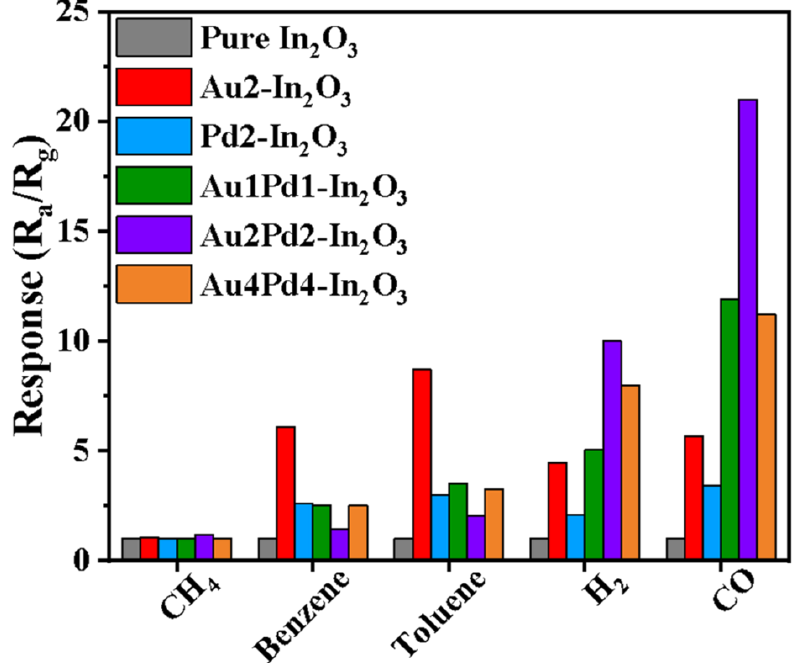
Figure 8. Gas responses of gas sensors based on six samples to various 100 ppm gases at 180 °C.